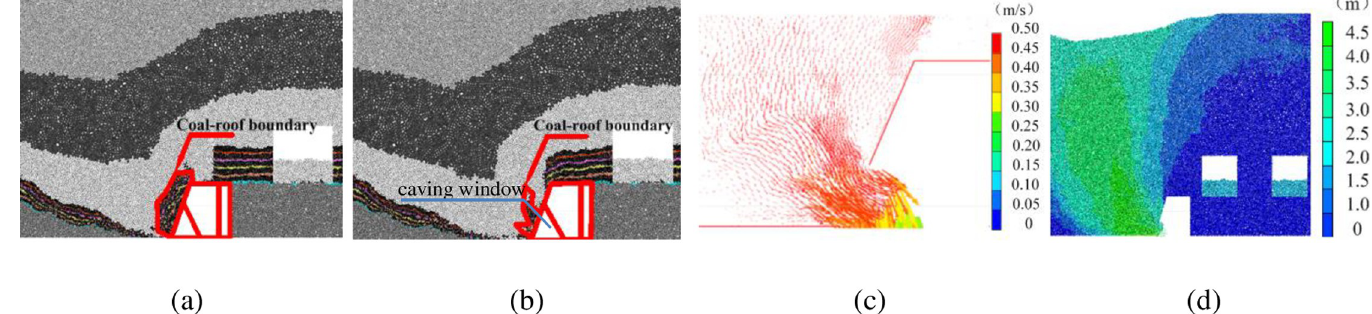
Fig 4. Coal and roof caving characteristics after 9m of face advance below previous entries in upper seam: (a) Coal-roof mass boundary before caving; (b) Coal-roof mass boundary after caving; (c) Particle velocity vectors at caving window; (d) Particle displacement.